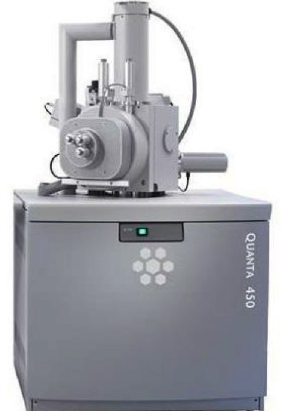
Figure 3: FEI Quanta 200 FEG environmental electronic scanning electron microscopy.